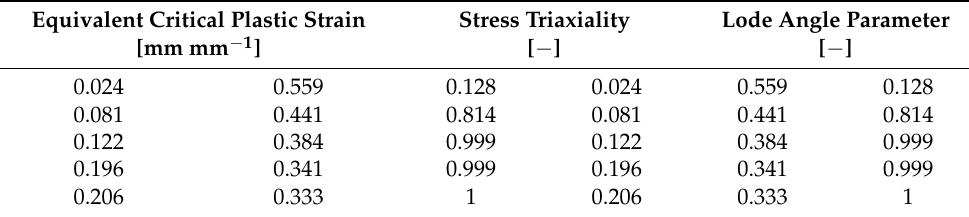
Figure 5. Equivalent plastic strain ( a ), stress triaxiality ( b ) and Lode angle parameter ( c ) variation with the distance from the centre of the specimen to the extremities. Table 1. Equivalent critical plastic strain and Lode angle parameter variation with stress triaxiality for the notched flat specimens.